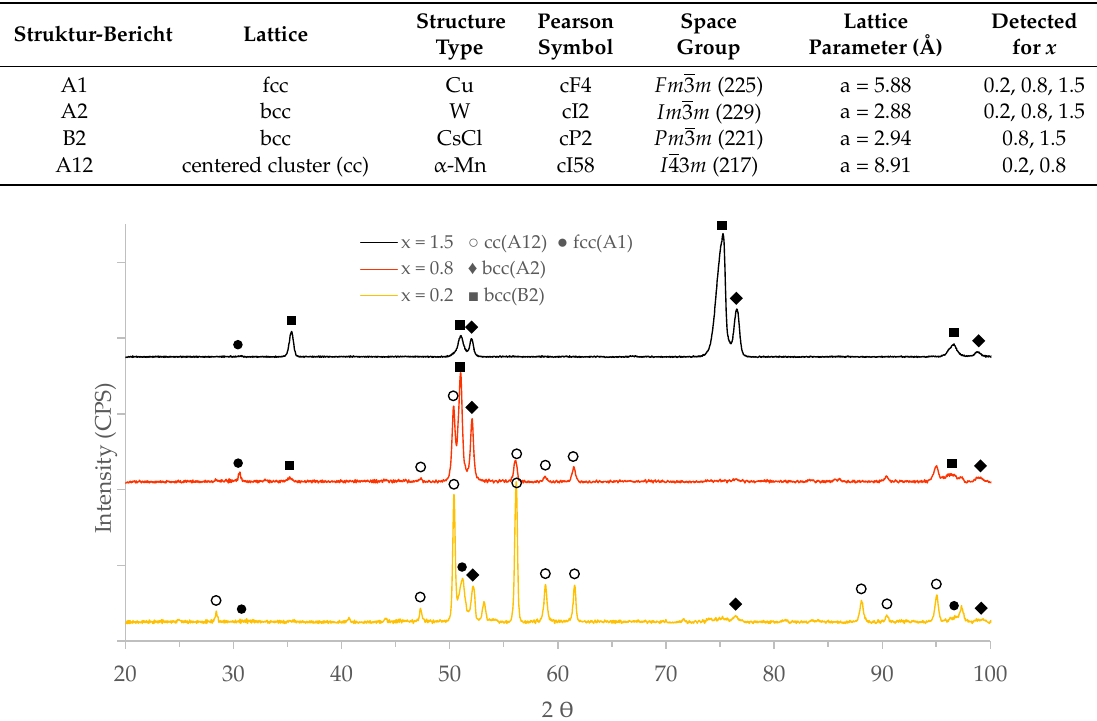
Figure 3. XRD diffraction diagrams of the cast Al x CoCrFeNiTi alloy for x = 0.2, 0.8, and 1.5.